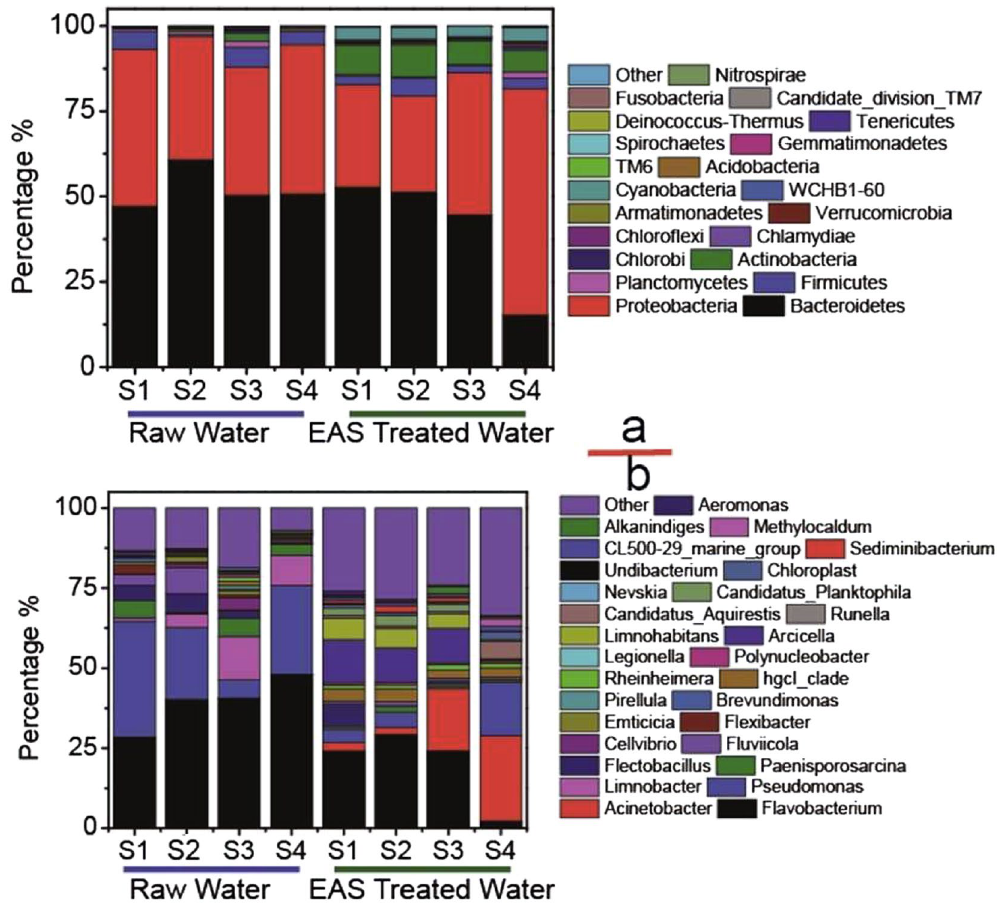
Figure 4. Comparison of microbial community structure (phylum level: a ; genus level: b ) in study water body before and after 30 days’ EAS